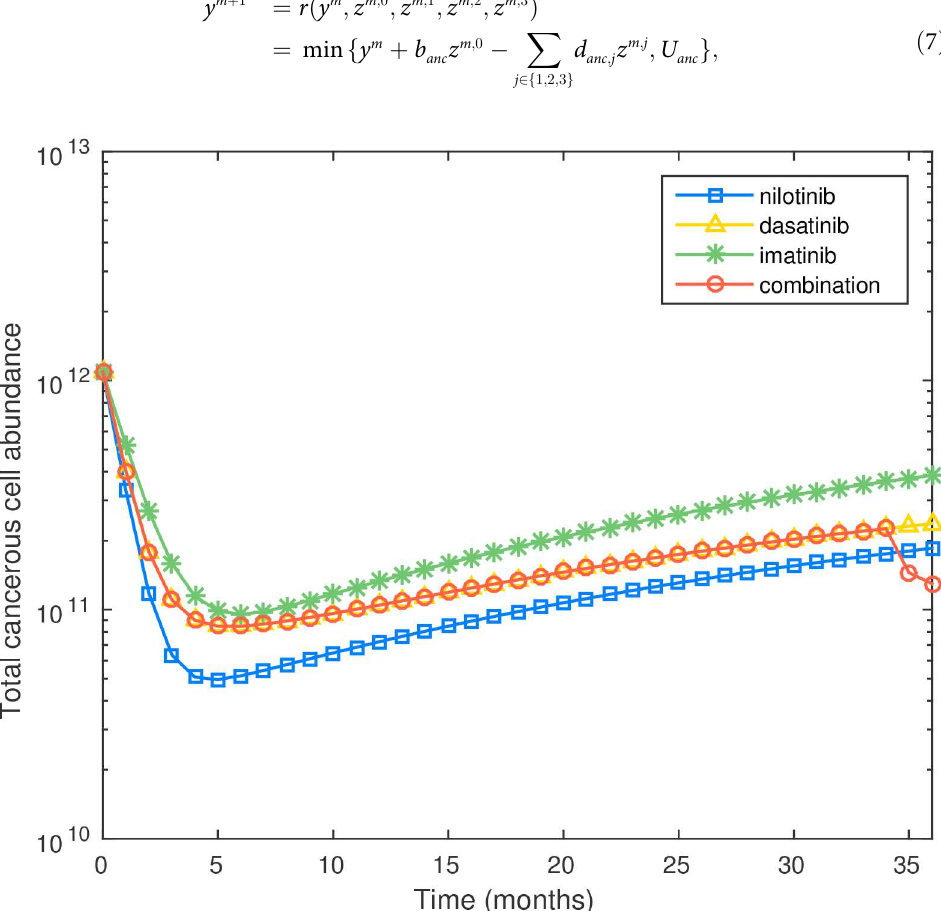
Fig 6. The cell dynamics with F317L and E255K preexisting